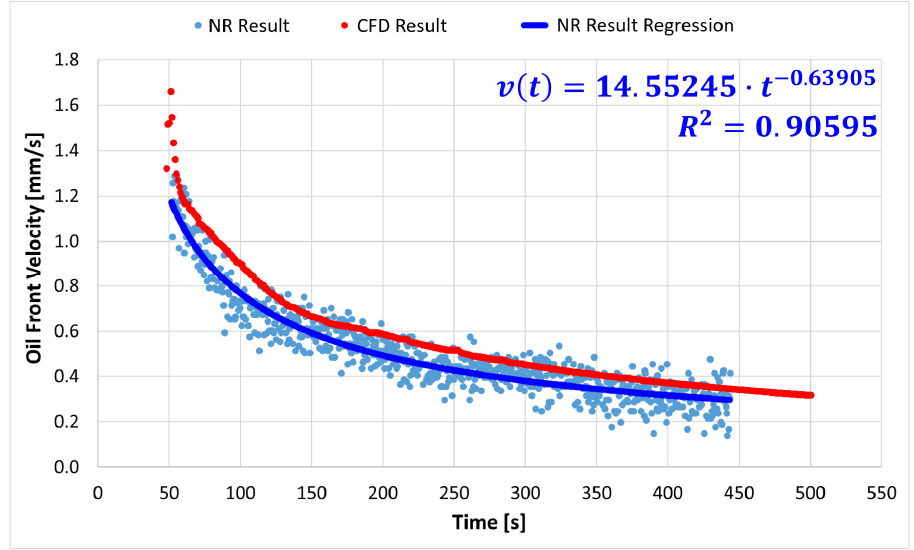
Figure 19. Oil front velocity comparison for “Bo tt om” case.